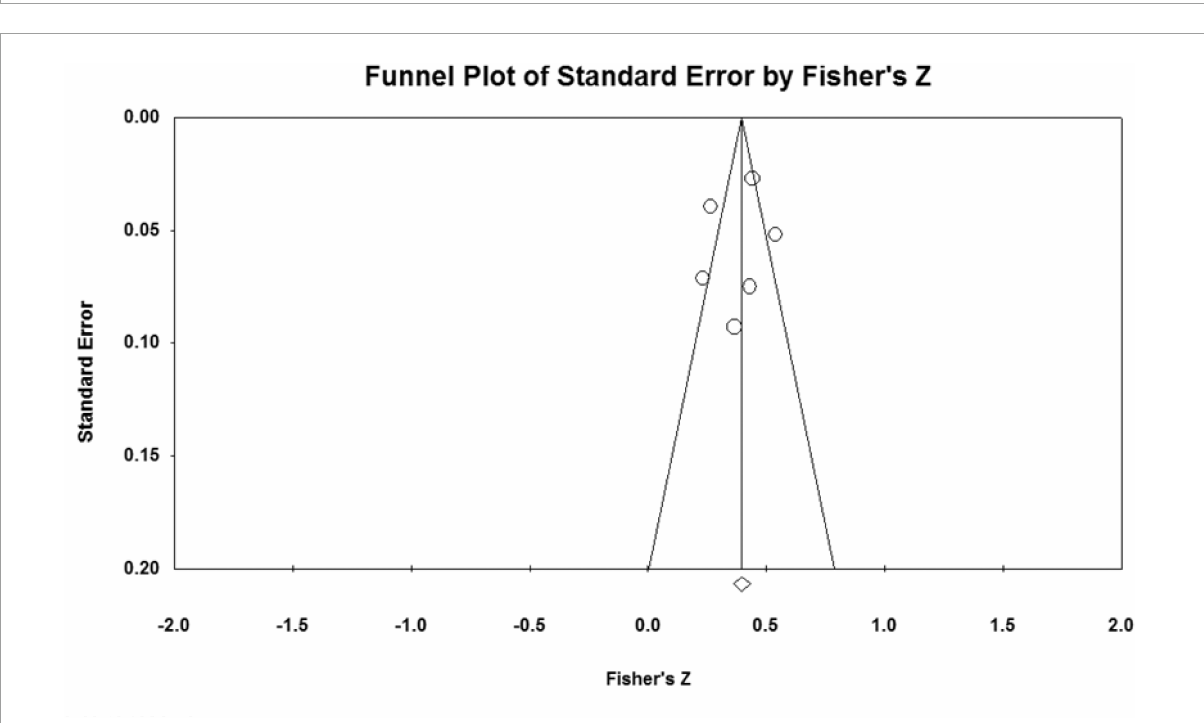
FIGURE6 Funnel plot of the relationship between inconsistent parenting and sibling conflicts studies.